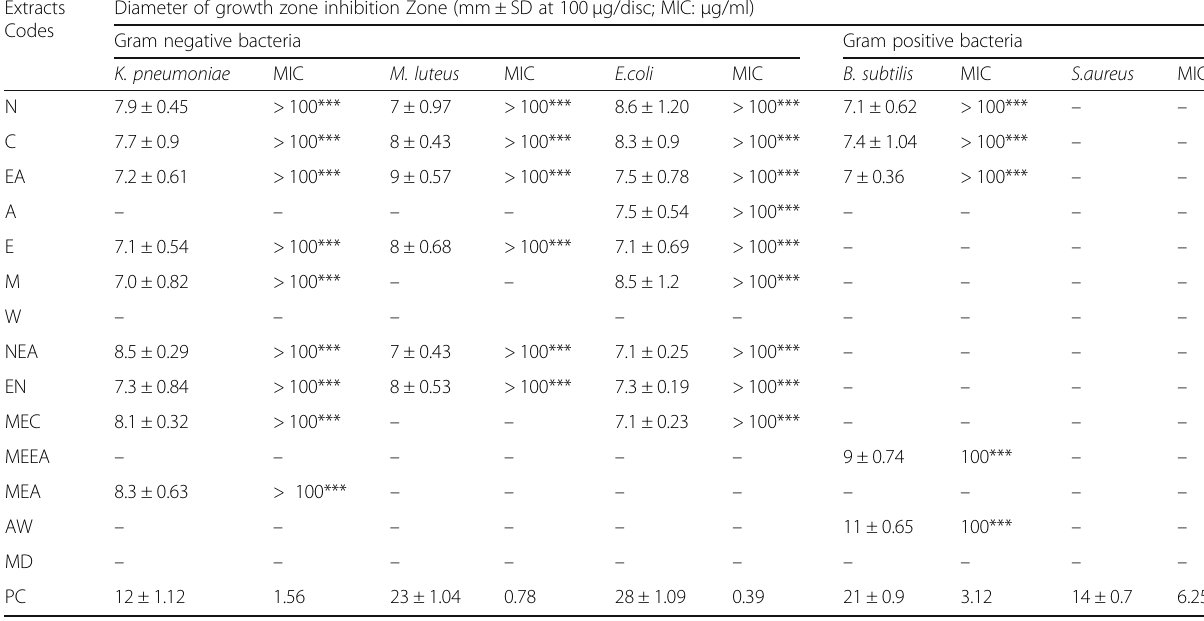
Table 3 Antibacterial activity of A. lasiantha extracts against pathogenic bacteria Extracts Codes